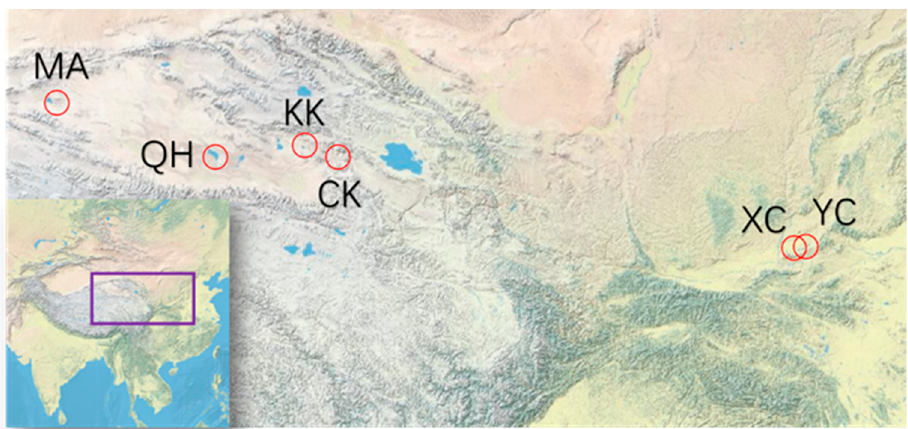
Figure 1. Sampling sites in Shanxi and Qinghai provinces, China.